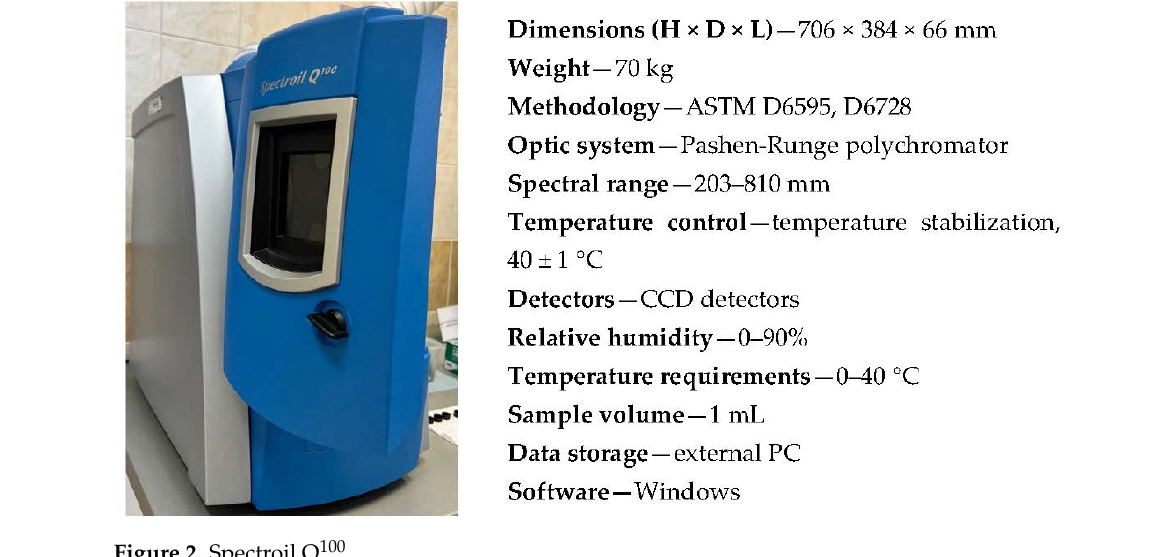
Figure 2. Spectroil Q 100 .